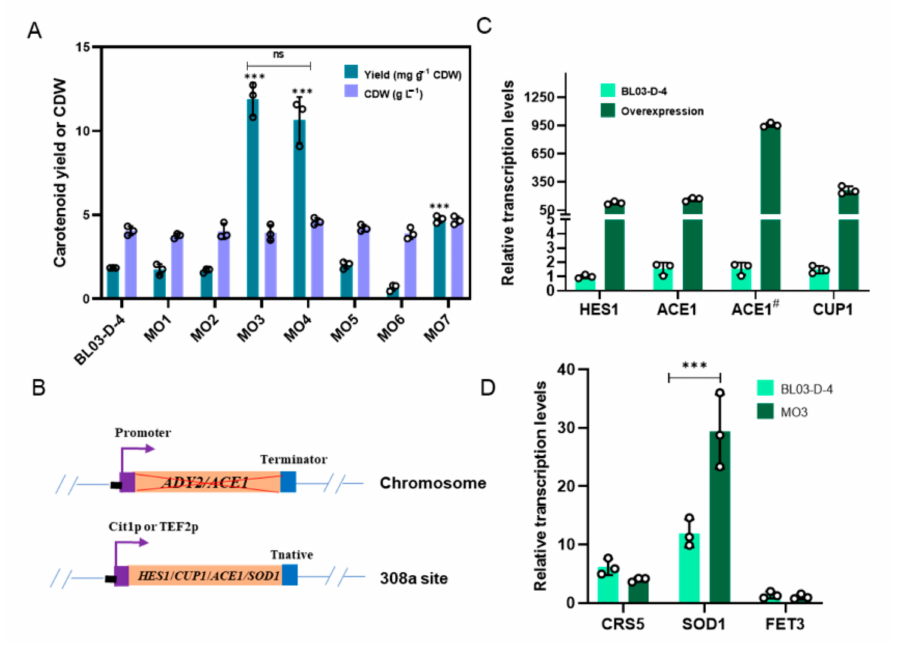
Figure 4. Reverse engineering of target gene mutation and overexpression for carotenoid accumu- lation in the YPD2 media for 96 h. MO1, deletion of ADY2 ; MO2, overexpression of HES1 ; MO3, overexpression of ACE1 under Cit1 promoter; MO4, overexpression of ACE1 under TEF2 promoter; MO5, overexpression of CUP1 ; MO6, deletion of ACE1 ; MO7, overexpression of SOD1 ( A ). Schematic explaining gene mutation and overexpression; purple arrows represented promoter ( B ). Relative transcription levels of HES1 , ACE1 , and CUP1 overexpressed under Cit1 promoter compared to BL03-D-4; ACE1 # , ACE1 overexpressed under TEF2 promoter; strains were cultivated in YPD2 media for 24 h ( C ). Relative transcription levels of CRS5 , SOD1 , and FET3 in MO3 compared to BL03-D-4 in YPD2 media for 24 h ( D ). Data represent the means and standard deviations of three biological replicates (small circles). ***: significantly different based on two-tailed Student’s t -test ( p < 0.001), ns: not significant ( p > 0.05).